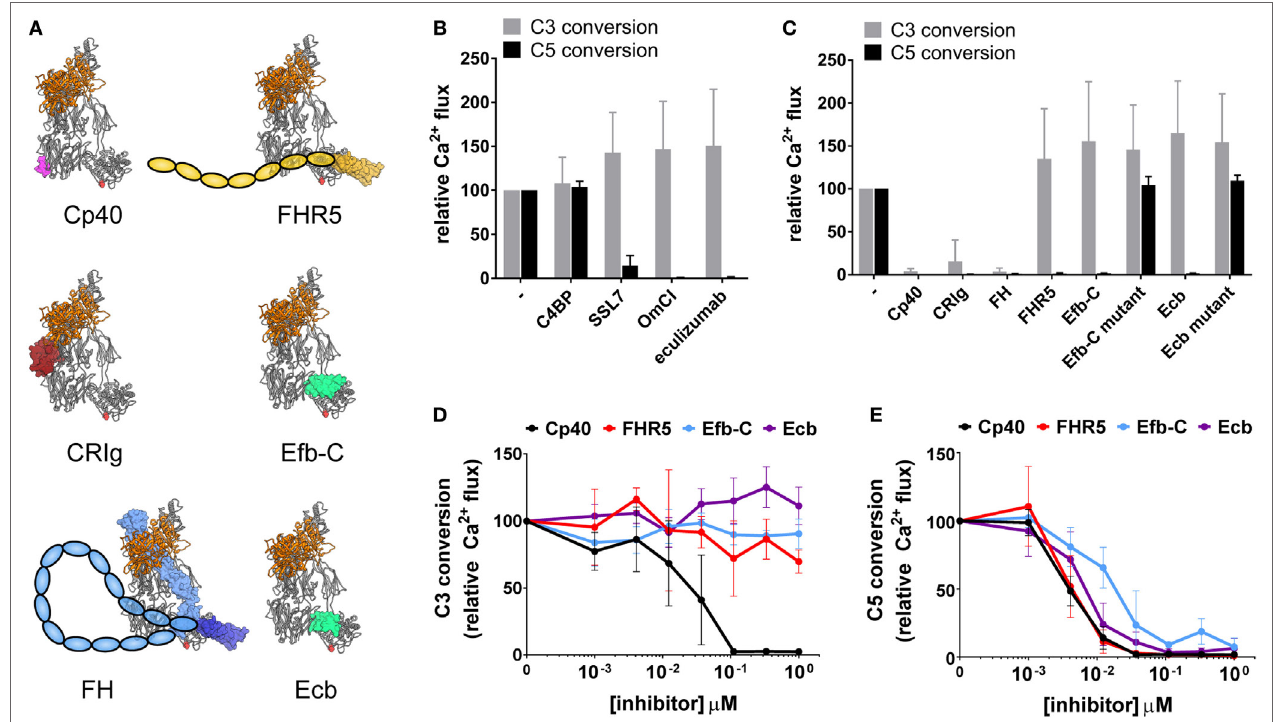
FigUre 3 | C3b-binding molecules FHR5 and Efb-C/Ecb selectively inhibit C5 conversion by alternative pathway (AP) convertases. (a) Structural models of the C3bBb convertase with C3b-binding molecules. The structure of C3bBb [from the C3bBb-SCIN dimer structure, PDB 2WIN (55)] is identical to the convertase shown in Figures 1c,D with C3b (gray) and Bb (orange) shown as ribbons, and in the same orientation, with the C3b–C3b dimerization site (as shown in Figure 1c , right) on the left side of the convertase. C3b-binding molecules are shown as molecular surfaces; Cp40 (magenta) is based on the C3c–compstatin complex structure [PDB 2QKI (41)], CRIg (dark red) is based on the C3b–CRIg complex structure [PDB 2ICF (31)], FH is based on the C3b–FH (1–4) structure [light blue, PDB 2WII (43)] and the C3d–FH (19–20) structure [dark blue, PDB 2XQW (44)], FHR5 (yellow) is modeled from the C3d–FH (19–20) structure [PDB 2XQW (44)], Efb-C (spring green) is based on the C3d–Efb-C structure [PDB 2GOX (21)], and Ecb (spring green) is based on the C3d–Ehp structure [PDB 2NOJ (23)]. For FH and FHR5 only some domains are structurally resolved. Additional domains are represented by colored ovals. (B–e) Conversion of C3 and C5 (0.1 µM) in the AP convertase model in the presence of complement-binding molecules measured by calcium mobilization in U937-C3aR and U937-C5aR cells, respectively. Conversion is shown as a percentage relative to the control without inhibitor. Data of three independent experiments, presented as mean ± SD. (B) C5-binding molecules SSL7, OmCI, and eculizumab (all 1 µM) inhibit AP C5 but not C3 conversion. C4b-binding protein has no effect in the AP model. (c) C3b-binding molecules Cp40, CRIg, and FH prevent both C3 and C5 conversion, while FHR5, Efb-C, and Ecb selectively inhibit C5 conversion. Mutant Efb-C and mutant Ecb are unable to bind C3b and thus do not exhibit inhibition. (D) FHR5, Efb-C, and Ecb do not affect C3 conversion, but (e) selectively inhibit C5 conversion in a dose-dependent manner. Cp40 was used as positive control, inhibiting both C3 and C5